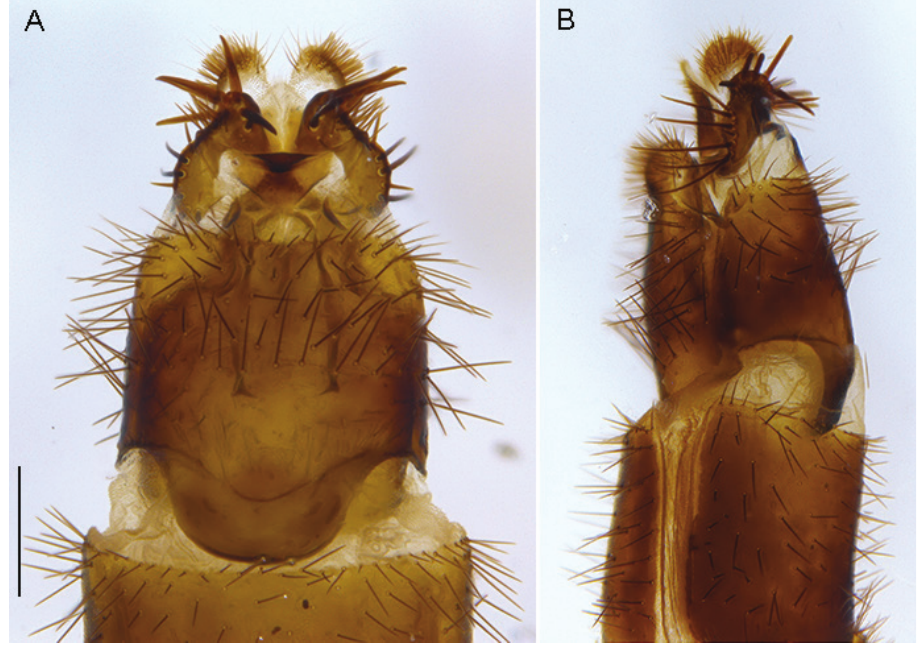
Figure 20. Sidarena yallingup sp. n.: Female genitalia: A dorsal view B lateral view. Scale line: 0.2 mm.